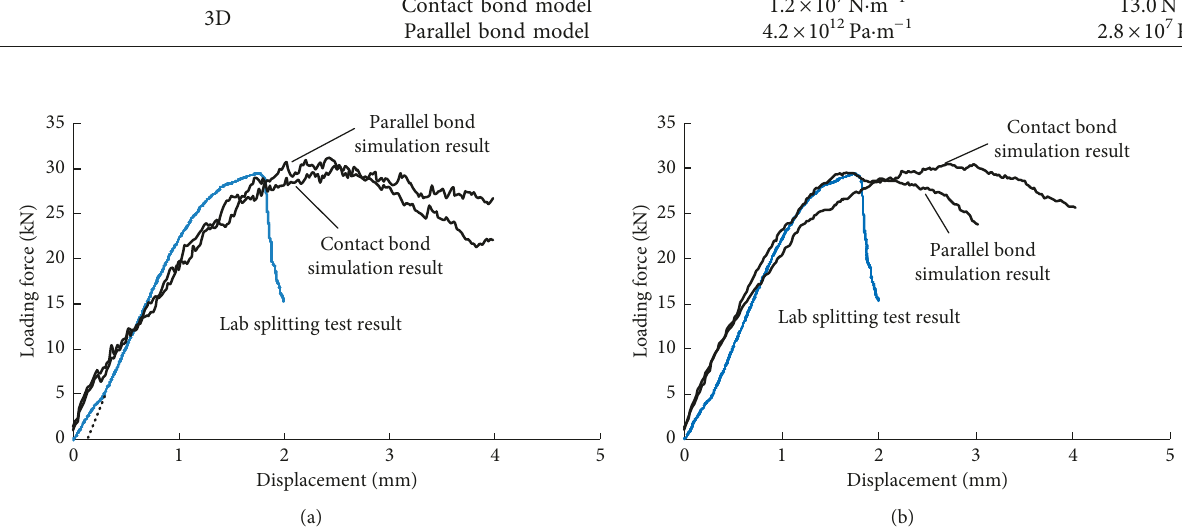
Figure 15: Comparison of the simulation results and lab test of AC-20 at 0 ° C. (a) 2D model. (b) 3D model [27].